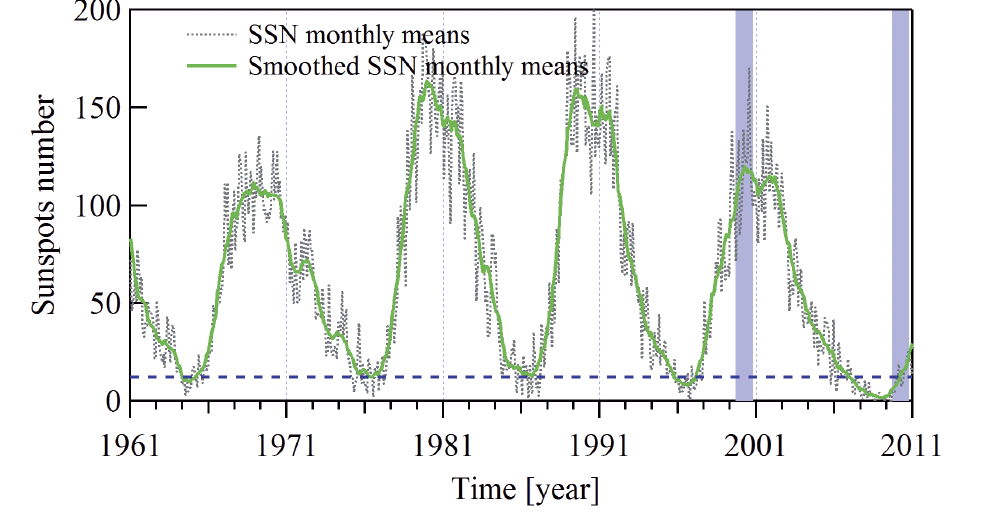
Figure 2. Values of sunspots number (SSN) between 1961.0 and 2011.0. Lilac areas indicate the time intervals during which magnetic surveys of 2000.0 and 2010.0 have been undertaken, the blue horizontal dashed line indicate the average number of sunspots observed between September 2009 and October